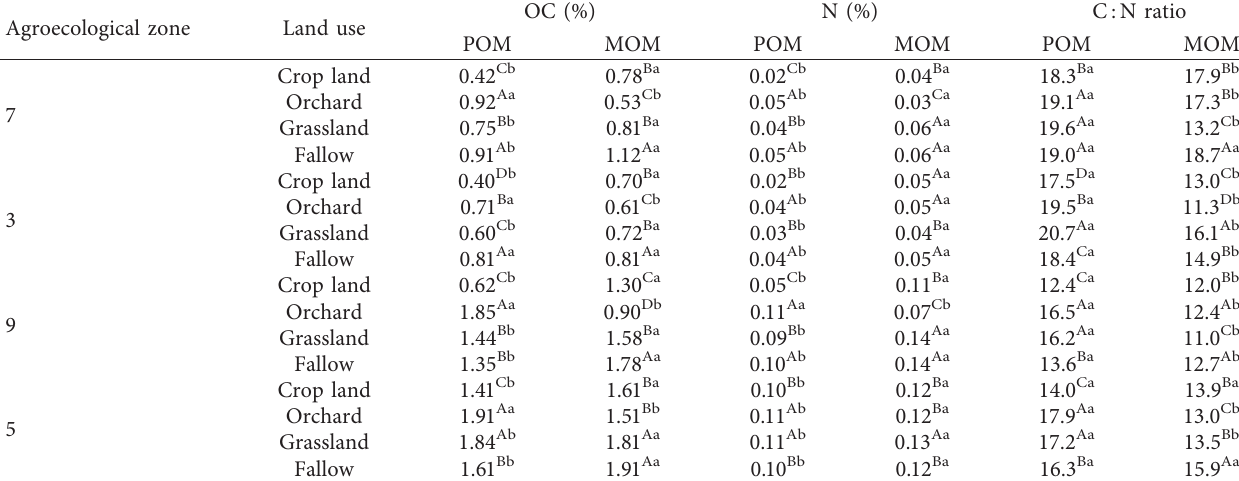
Here, POM (particulate organic matter) ≥ 53 µ m and MOM (mineral associated organic matter) ≤ 53 µ m. Standard error (S.E.) for OC � 0.00–0.09, N � 0–0.01 and C:N ratio � 0.01–0.65. Uppercase letters indicate significant differences ( p < 0 . 001) among land uses at corresponding fraction size for each AEZ and lowercase letters indicate significant differences ( p < 0 . 001) between fractions at corresponding land use for each AEZ.